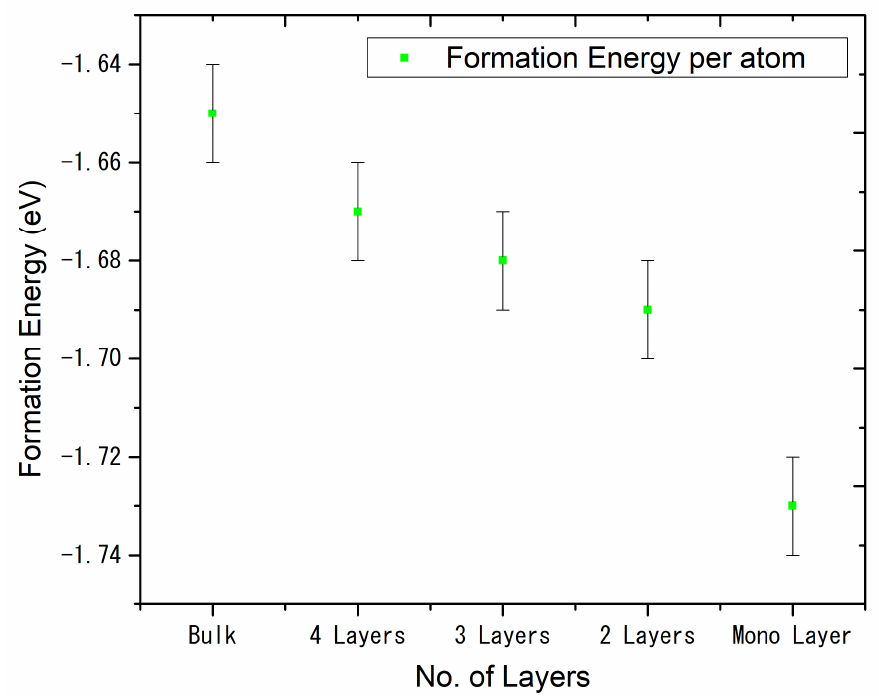
Figure 7. Formation Energy per atom as a function of several layers of SnO.